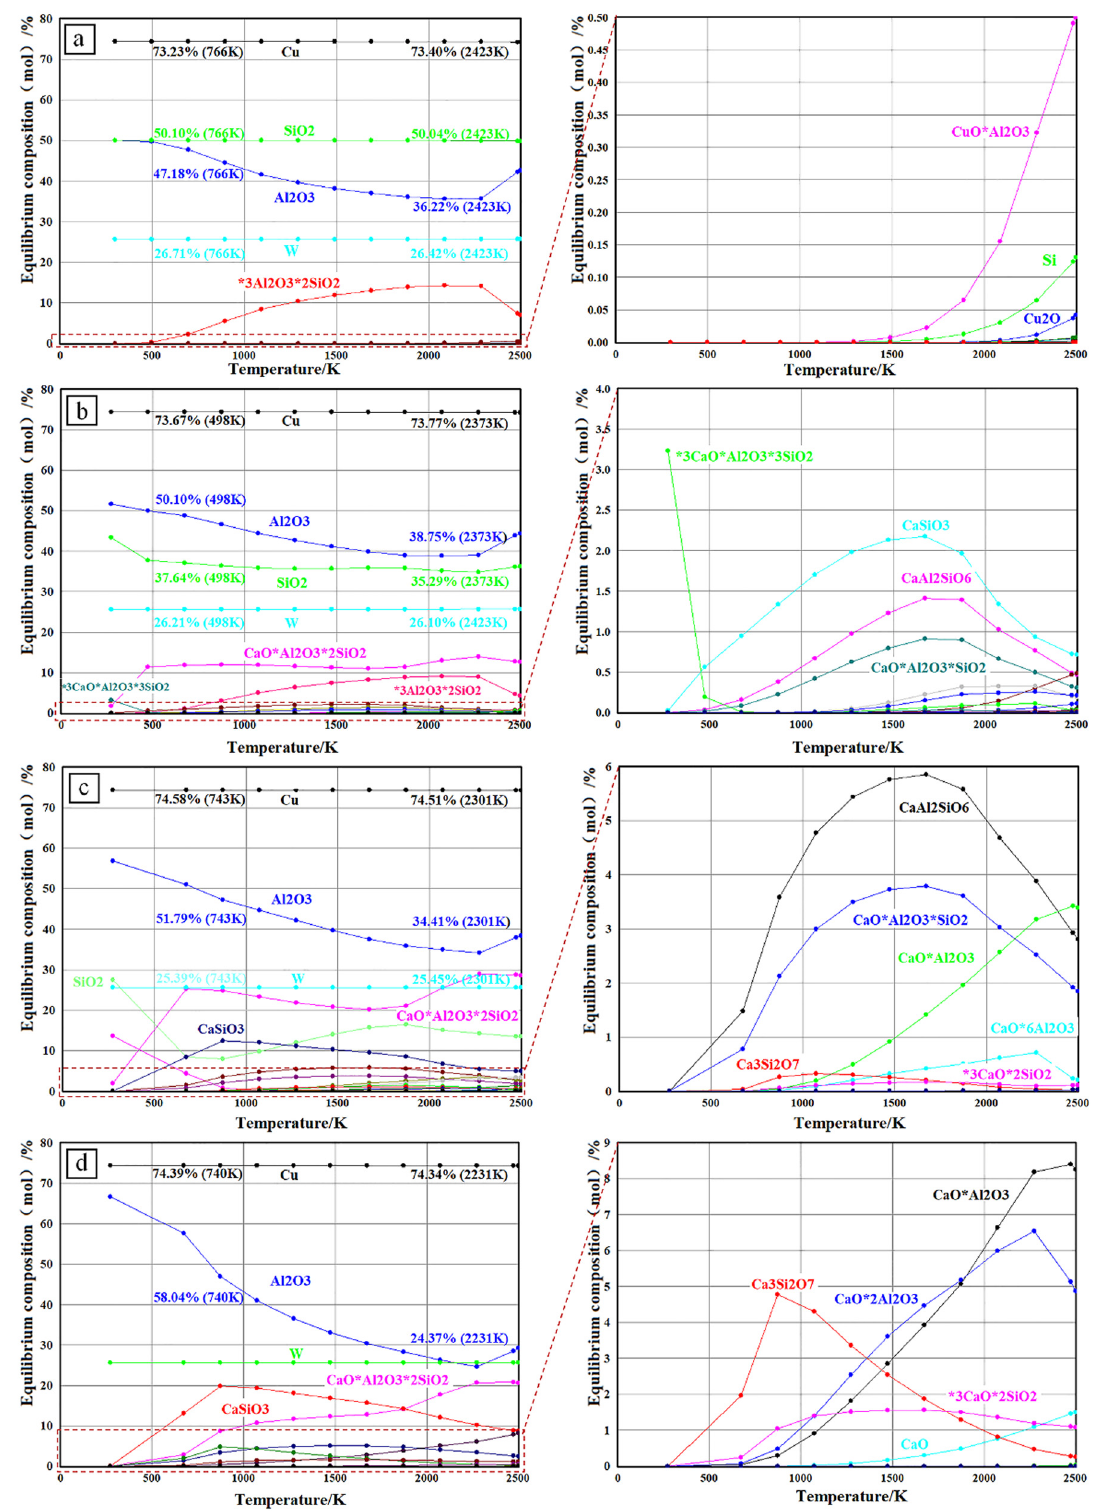
Figure 2: Thermodynamic equilibrium of the Al – Si – CuO – WO 3 – CaO system with di ff erent R ( C/A ) ( a: 0, b: 0.2, c: 0.6, and d: 1.0 )